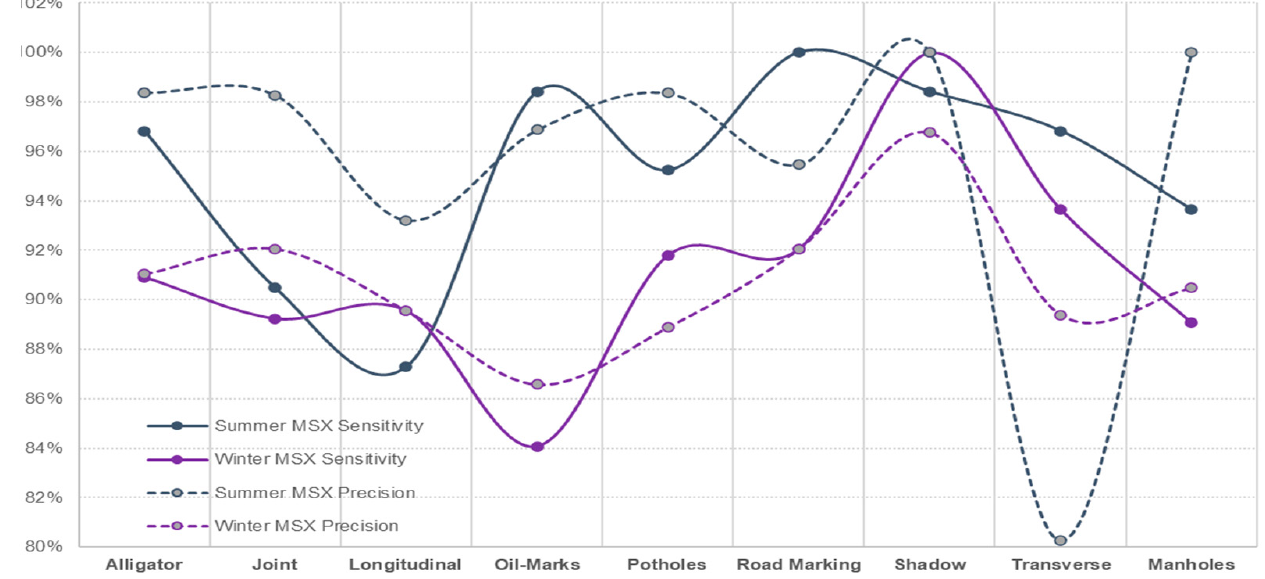
Figure 17. Comparing summer and winter conditions for MSX images.